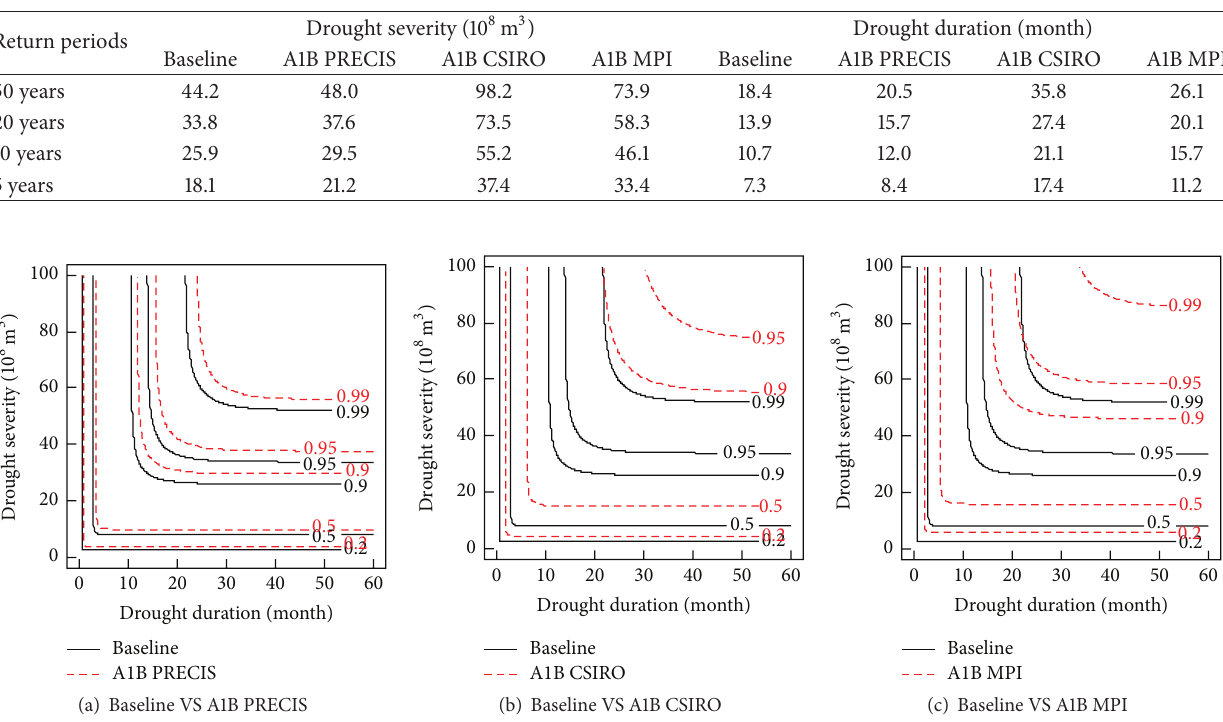
Figure 8: Bivariate joint probability of drought duration and severity under baseline and three A1B